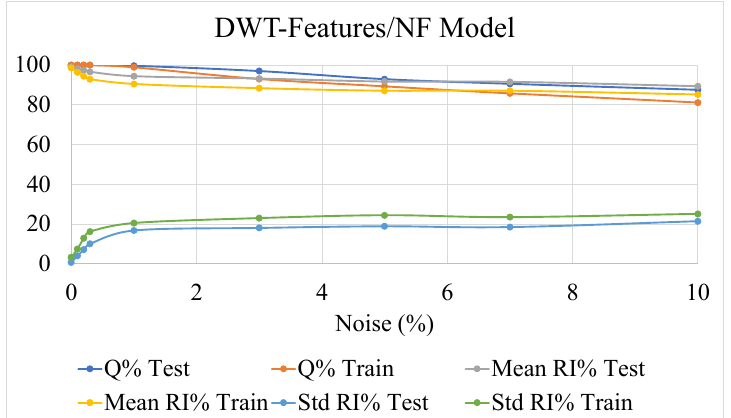
Figure 11. The behavior of the Neuro Fuzzy inference systems fed by DWT-based features, as a function of different levels of noise added to the dataset. Results for indexes (11), (13) and (14) calculated for reliability index (12) are shown.